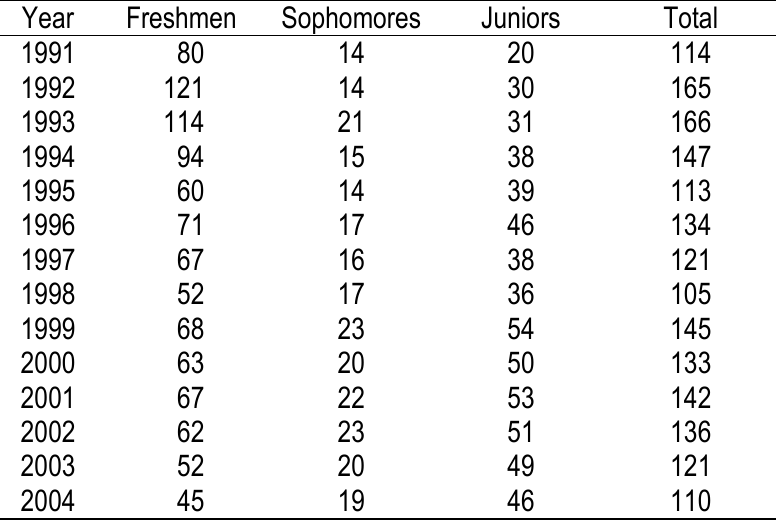
Table 1. Number of yearly applicants to the KNOU (thousand persons)